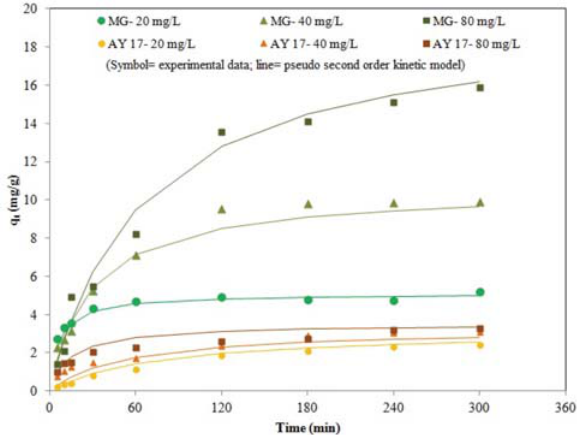
Figure 10. Typical plots of comparison between the measured and pseudo second order modeled time profiles for MG and AY 17 re- moval